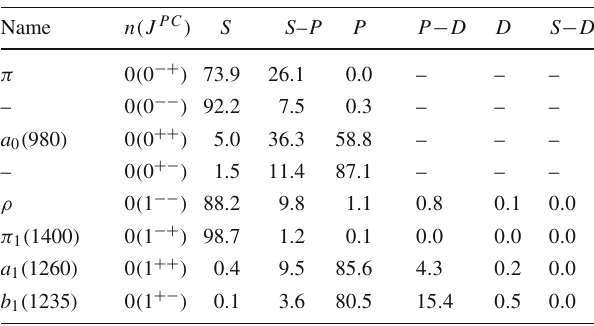
Table 2 Orbital angular momentum content of ground states with J = 0 , 1. Numbers are given in %. For an illustration of the differ- ent contributions, see Fig.